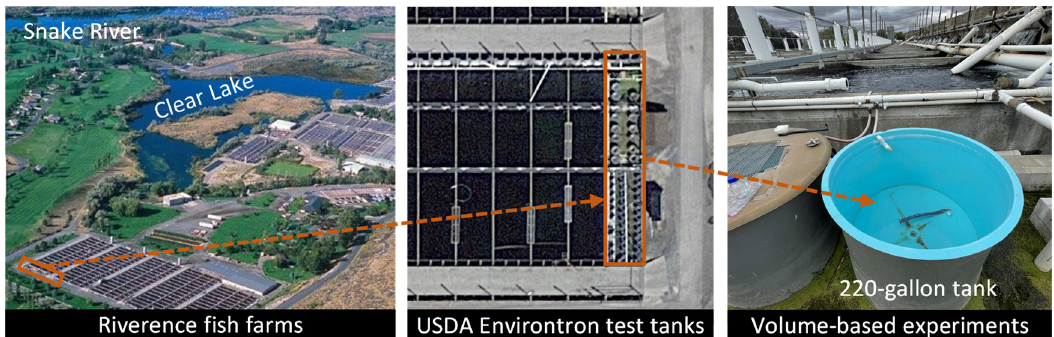
Figure 5. Field experiments, using USDA-ARS testing tanks at Riverence fish farm.